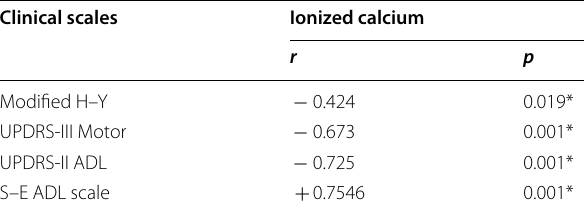
SD standard deviation, Modified H–Y scale: modified Hoehn and Yahr scale, UPDRS-III_motor: Unified Parkinson’s Disease Rating Scale part III, UPDRS-ADL: Unified Parkinson’s Disease Rating Scale Activities of Daily Living part II, S–E ADL scale: Schwab and England Activities of Daily Living Scale, r correlation coefficient, p < 0.05 is significant, *